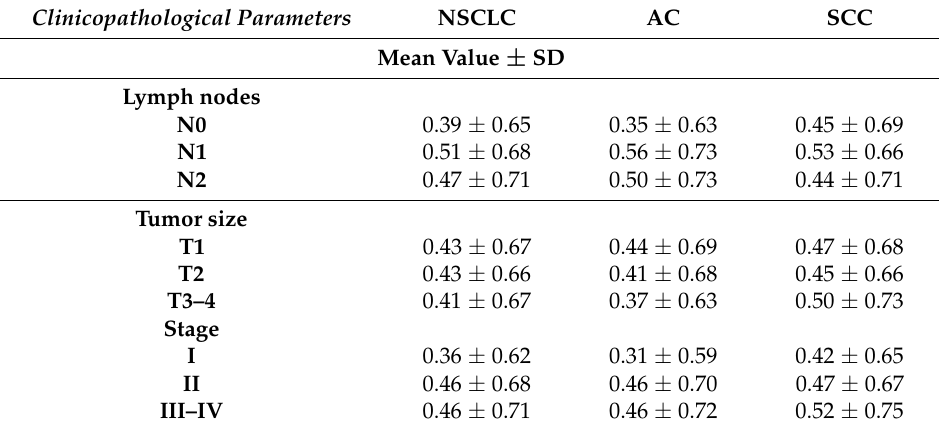
(0–1) and high (2) levels of PD-L1